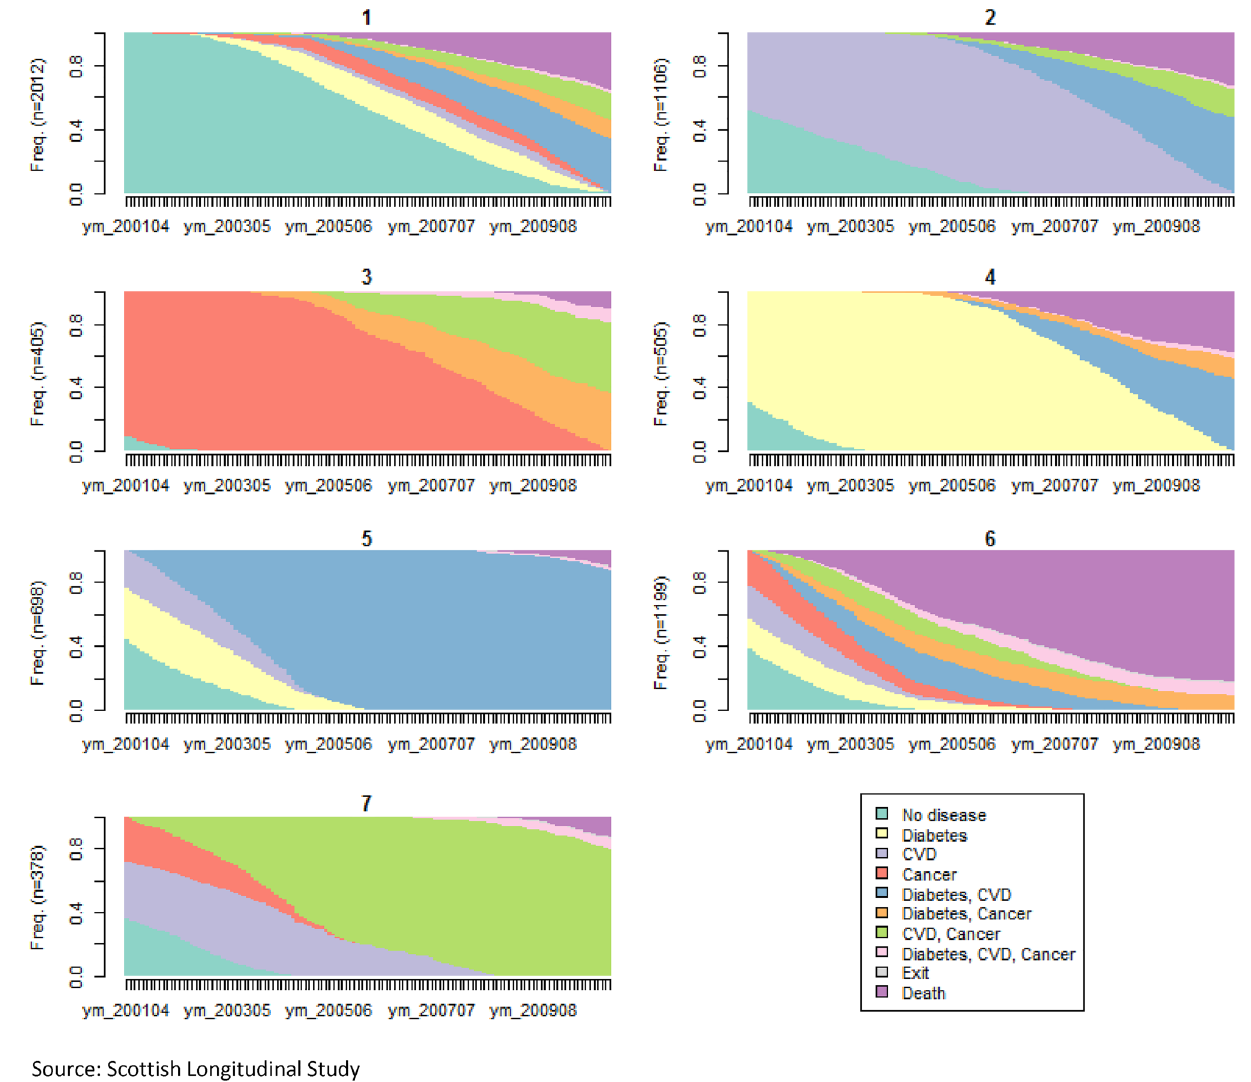
Figure 1. Chronogram for the 7-clusters solution. Source: Scottish Longitudinal